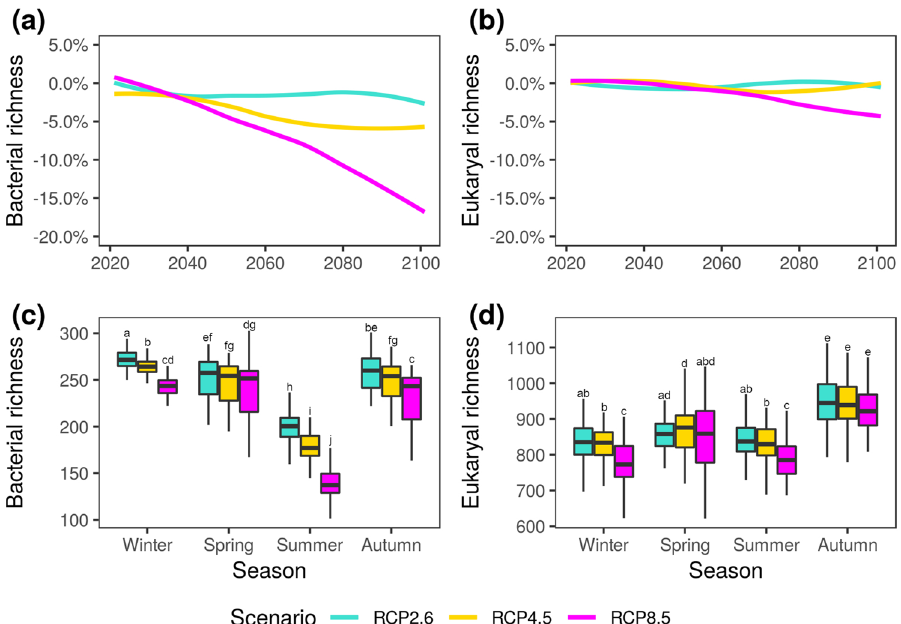
Figure 2. Microbial richness predicted in three different climatic scenarios (RCP2.6, 4.5, and 8.5), corresponding to emissions decline, stabilization, or increase. ( a ) Bacterial or ( b ) eukaryal relative richness change for the period 2020–2100. ( c ) Bacterial or ( d ) eukaryal richness for seasons within the period 2081– 2100. The boxes are delimited by quartiles Q1 and Q3, whiskers correspond to 1.5 interquartile ranges from the corresponding quartile, and letters indicate between-group differences based on post-hoc analysis.